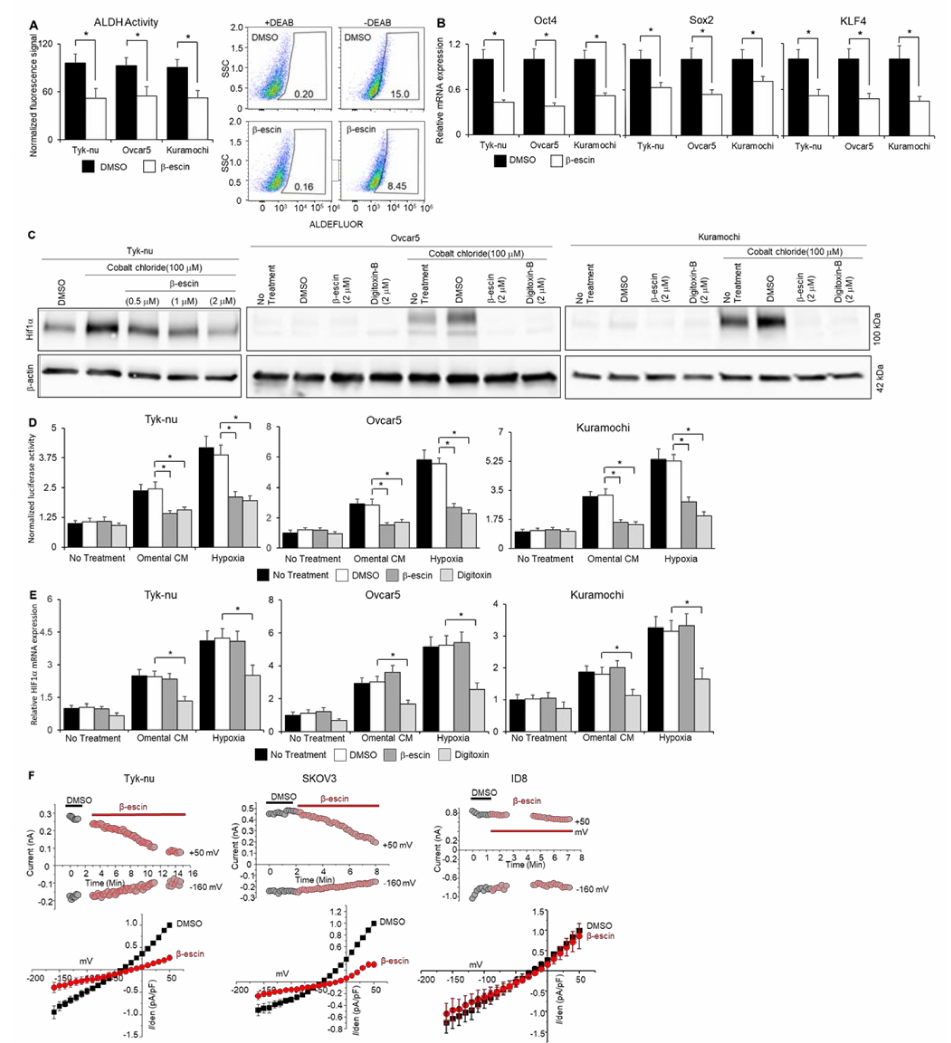
Figure 3. β -escin inhibits ALDH activity, stem cell marker expression, and HIF1 α stability in ovarian cancer cells and sodium − potassium pump currents. ( A ) The aldehyde-dehydrogenase (ALDH) activity was measured by flow cytometry in human OvCa cell spheroids after β -escin (10 µ M) treatment for 48 h with the ALDEFLUOR TM assay kit (mean ± standard deviation, n = 5). Representative images of the flow cytometry analysis of the ALDEFLUOR signal (FITC-Area) in Kuramochi OvCa spheroids. SSC—side scatter-height. * p < 0.05. ( B ) Stem cell markers; Sox2, Oct4, and KLF4 mRNA expression were measured by qRT-PCR in human OvCa cell spheroids after β -escin (10 µ M) and Digitoxin (0.002 µ M) treatment for 48 h. Mean ± standard deviation. *, n = 5–8. DMSO—dimethyl sulfoxide. ( C ) HIF1 α protein expression was measured by immunoblot analysis in human OvCa cells after β -escin, Digitoxin, or control treatment in combination or not